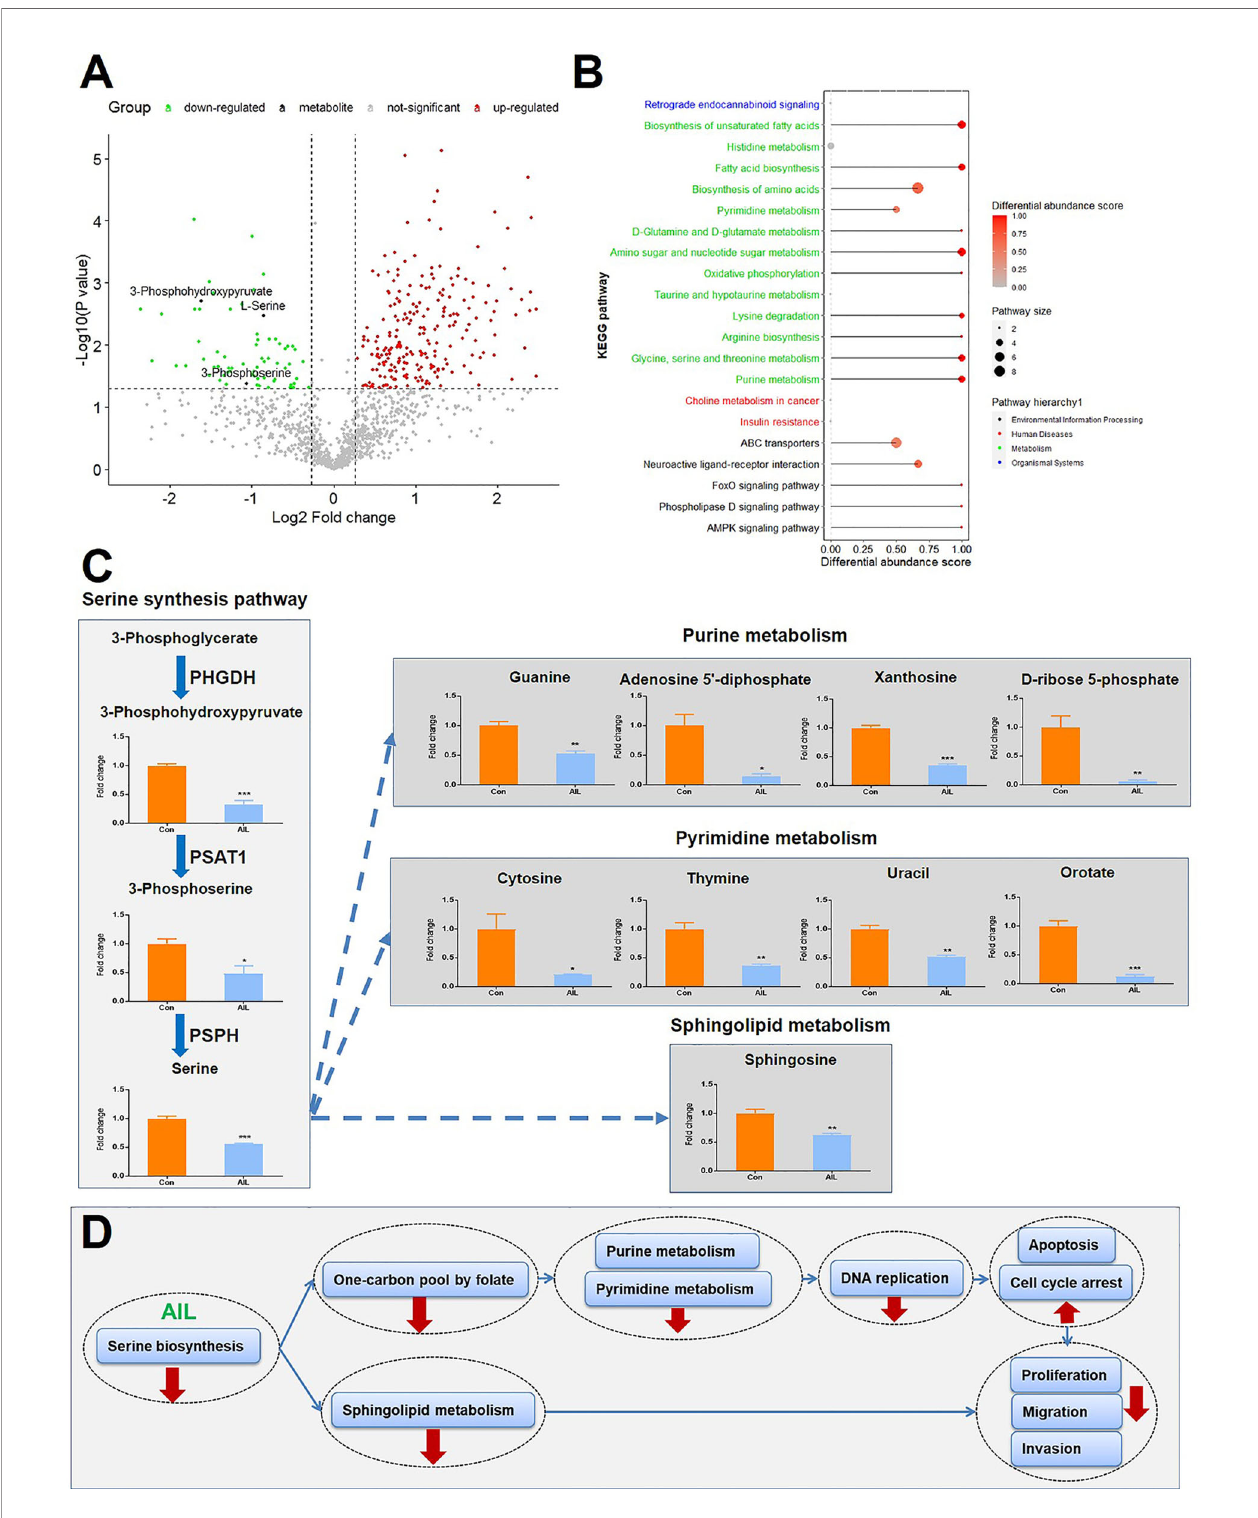
FIGURE 7 | Treatment with AIL led to reduced intermediate metabolites of the SSP and its downstream pathways. (A) Volcano plot of the global pro fi le of metabolites after AIL treatment, marked black metabolites are involved in the serine biosynthetic or metabolic pathway. (B) KEGG enrichment of differentially expressed metabolites, showing 21 signi fi cantly enriched pathways after AIL treatment. (C) Fold-changes in the intermediate metabolites of the SSP and its downstream pathways (* P < 0.05, ** P < 0.01, *** P < 0.001 compared with the control). (D) Proposed schematic overview of the antitumor mechanism of AIL in OS.